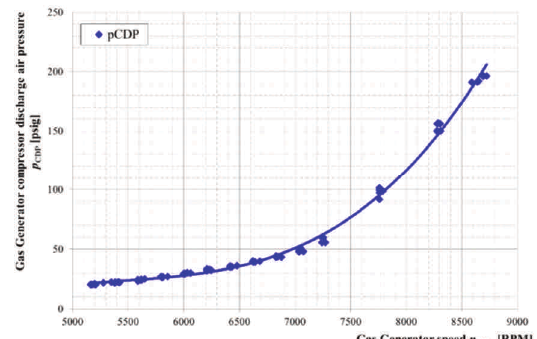
Fig. 9. Approximated function and the results of the measurements of gas generator compressor discharge air pressure p CDP , recorded for steady-state